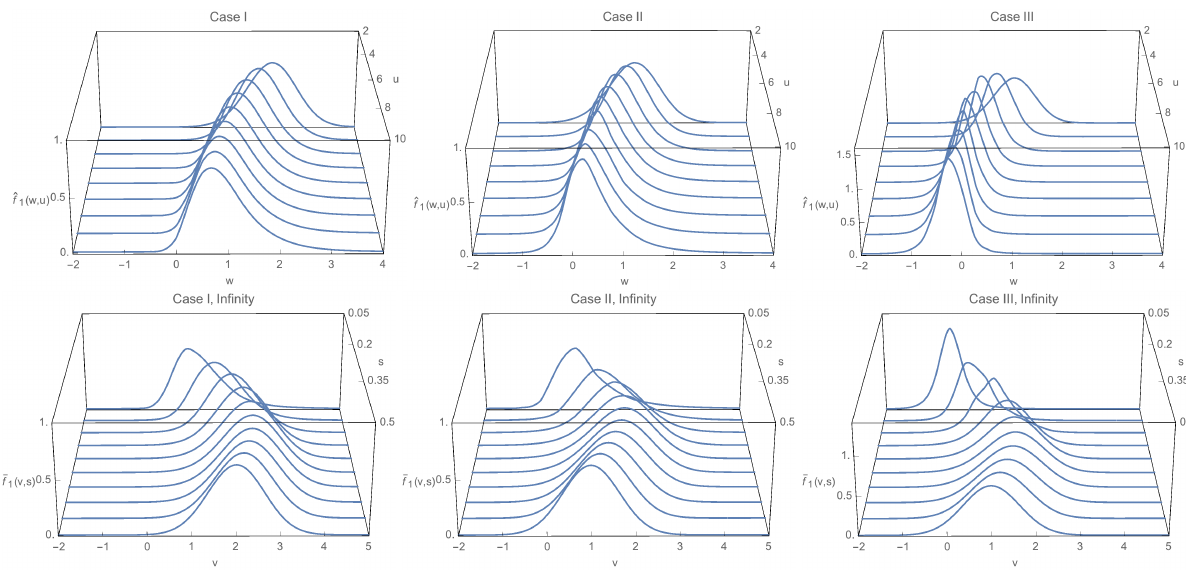
Fig. 1 Top: Plots of the 1-PDF of the solution SP, W ( u ) , to the random IVP (4) with u 0 = 1 given in (8), (11), (13) in Cases I–III at different values of u ∈ { 2 , 3 ,..., 10 } . Bottom: Plots of the 1-PDF of the solution SP, V ( s ) , to the random IVP (17) with s 0 = 0 . 5 given in (19), (20), (22) in Cases I–III at different values of s ∈ { 0 . 05 , 0 . 1 ,..., 0 . 5 } .